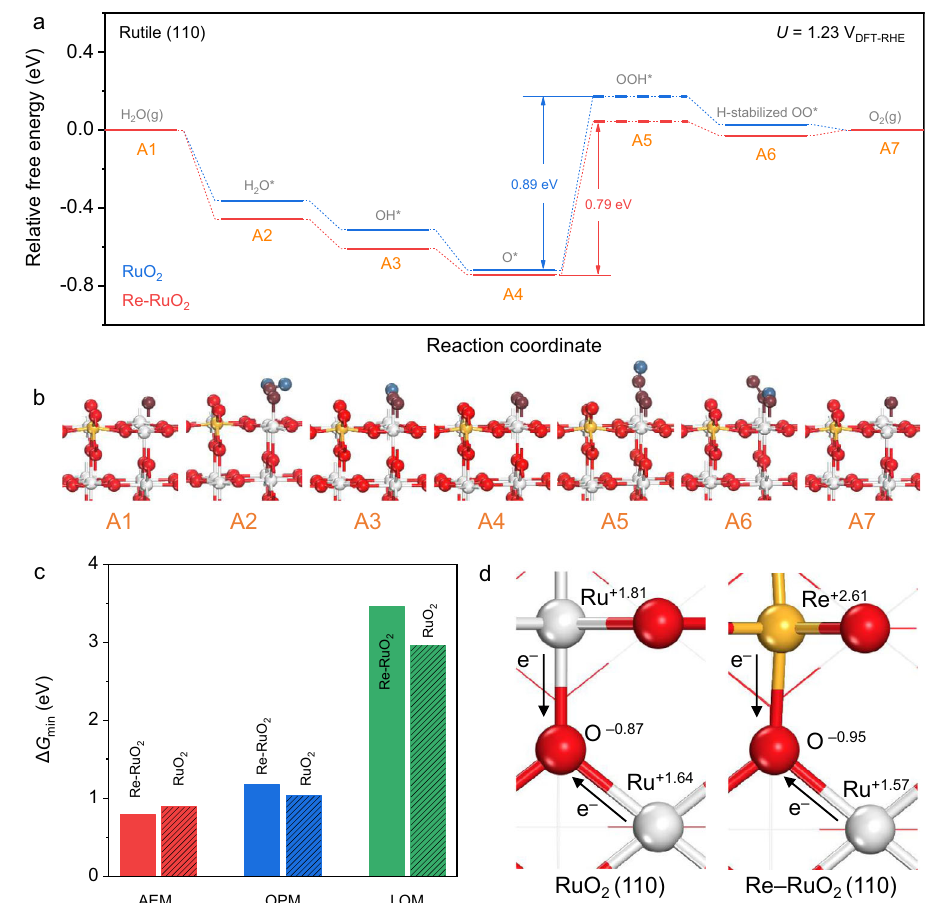
Fig.5|DFTsimulation.a , b FreeenergydiagramforOERonunsaturatedRusiteof Re 0.06 Ru 0.94 O 2 and RuO 2 at 1.23V versus RHE, showing six (6) possible inter- mediates for the (110) surfaces. Dashed lines indicate unstable – OOH precursor states, shown as H-stabilized OO*. c Minimum activation energy for different